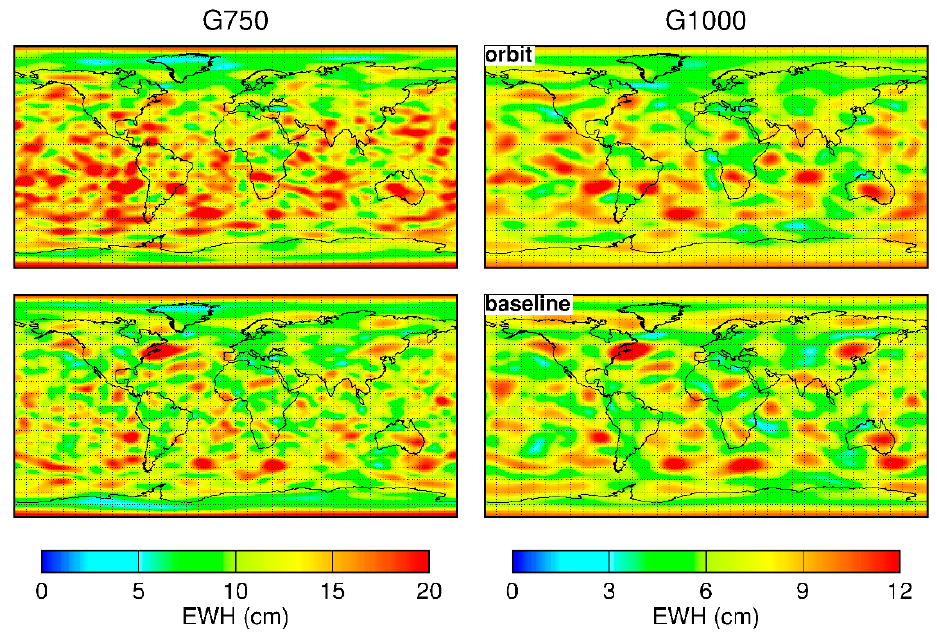
Figure 6. Geographical distribution of the gridded RMS differences with respect to WHU RL01 for different GPS-based solutions. The top and bottom rows show the results for the orbit and baseline solutions, respectively.